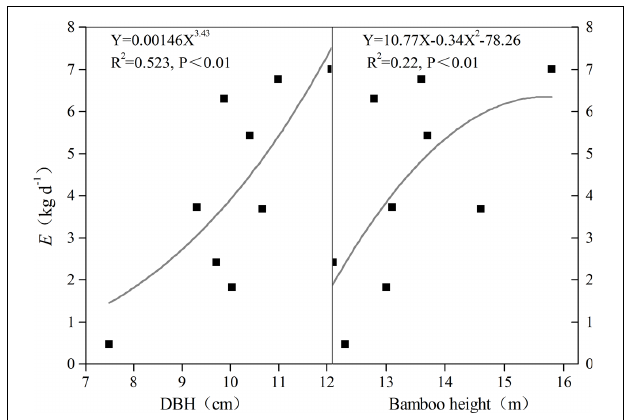
FIGURE 6 | Relationships between mean transpiration (E) and DBH and bamboo height ( n = 9